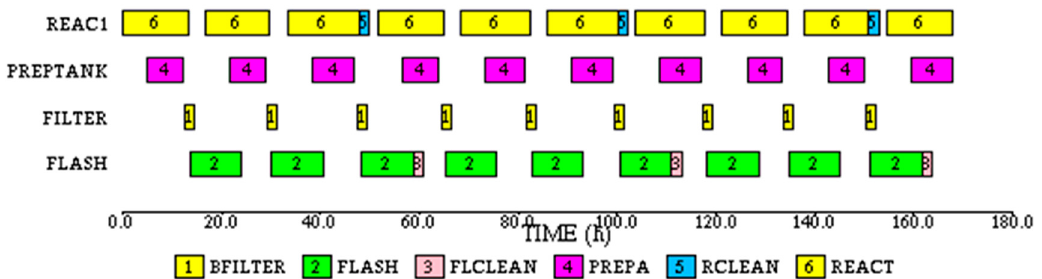
Figure 19. Composite Gantt chart for the specialty chemical process.